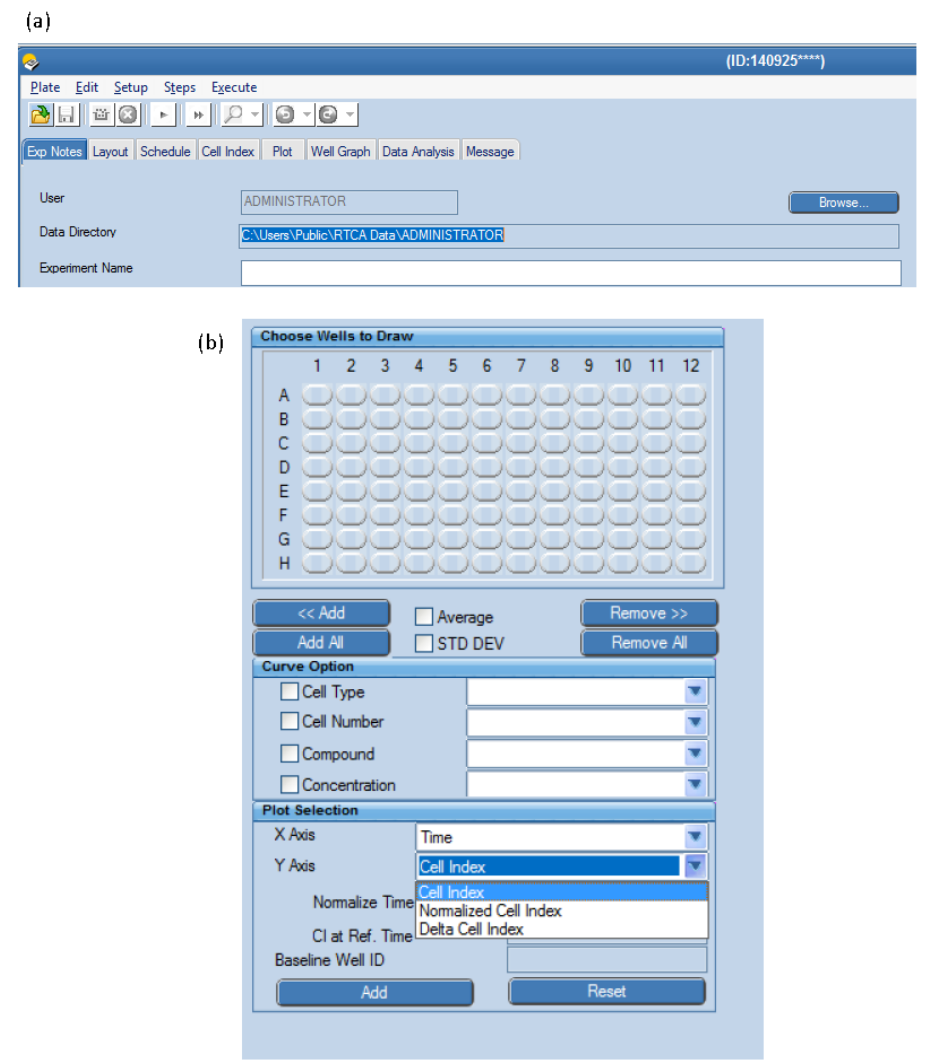
Figure A1. Screenshots of key software functionality. ( a ) The default software page showing the various page tabs; ( b ) highlighting how to switch between the Cell Index, Normalised Cell Index and the Delta Cell Index view in the Plot